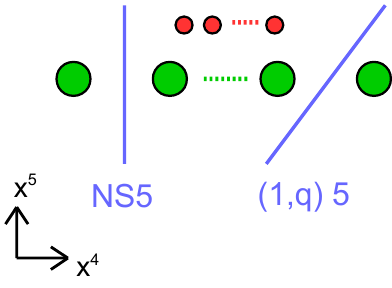
Figure 9 . Initial brane setup for the dyonic loop L 1 ;q , with an NS5 brane and a (1 ; q ) 5-brane.